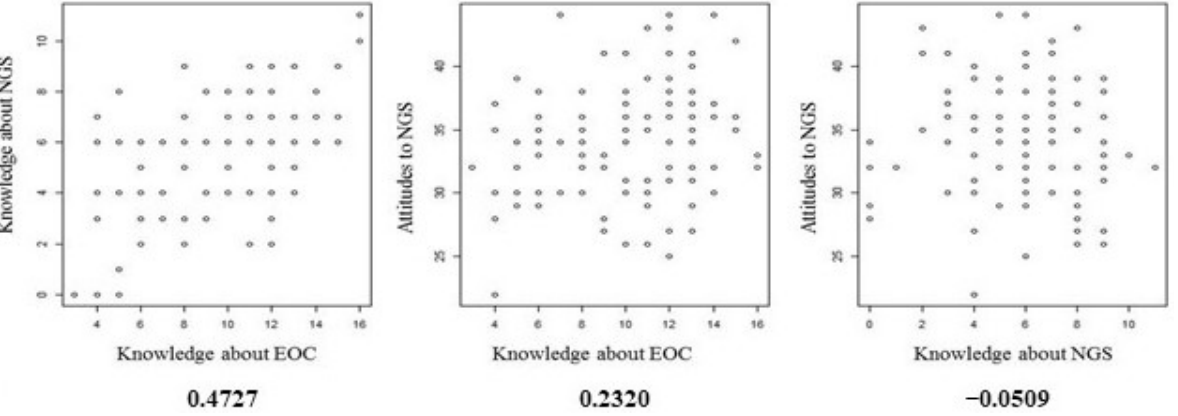
Figure 1. Attitude to next-generation sequencing.